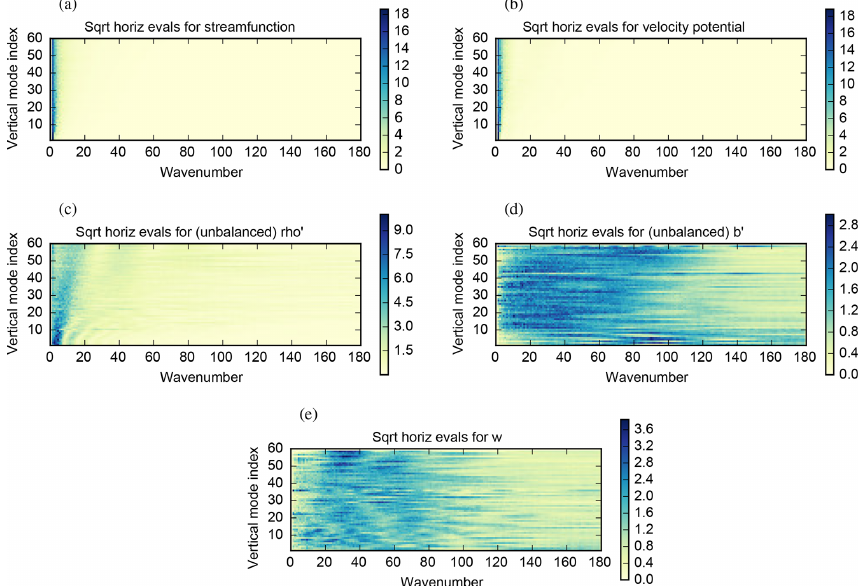
Figure 5. The square root of the horizontal variances (colours) as a function of horizontal wavenumber and vertical mode index for the five ˜ ρ (cid:48) u , (d) δ b (cid:48) u , and (e) δ w control parameters: (a) δ ψ , (b) δ χ vp , (c) δ